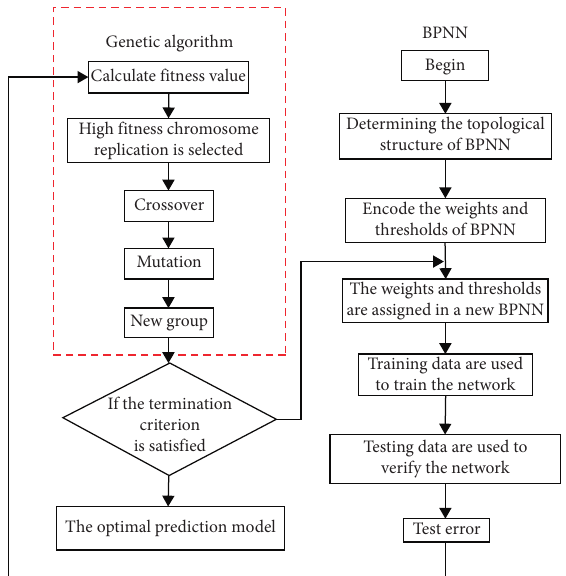
Figure 4: Flowchart of the GA-BPNN structure.